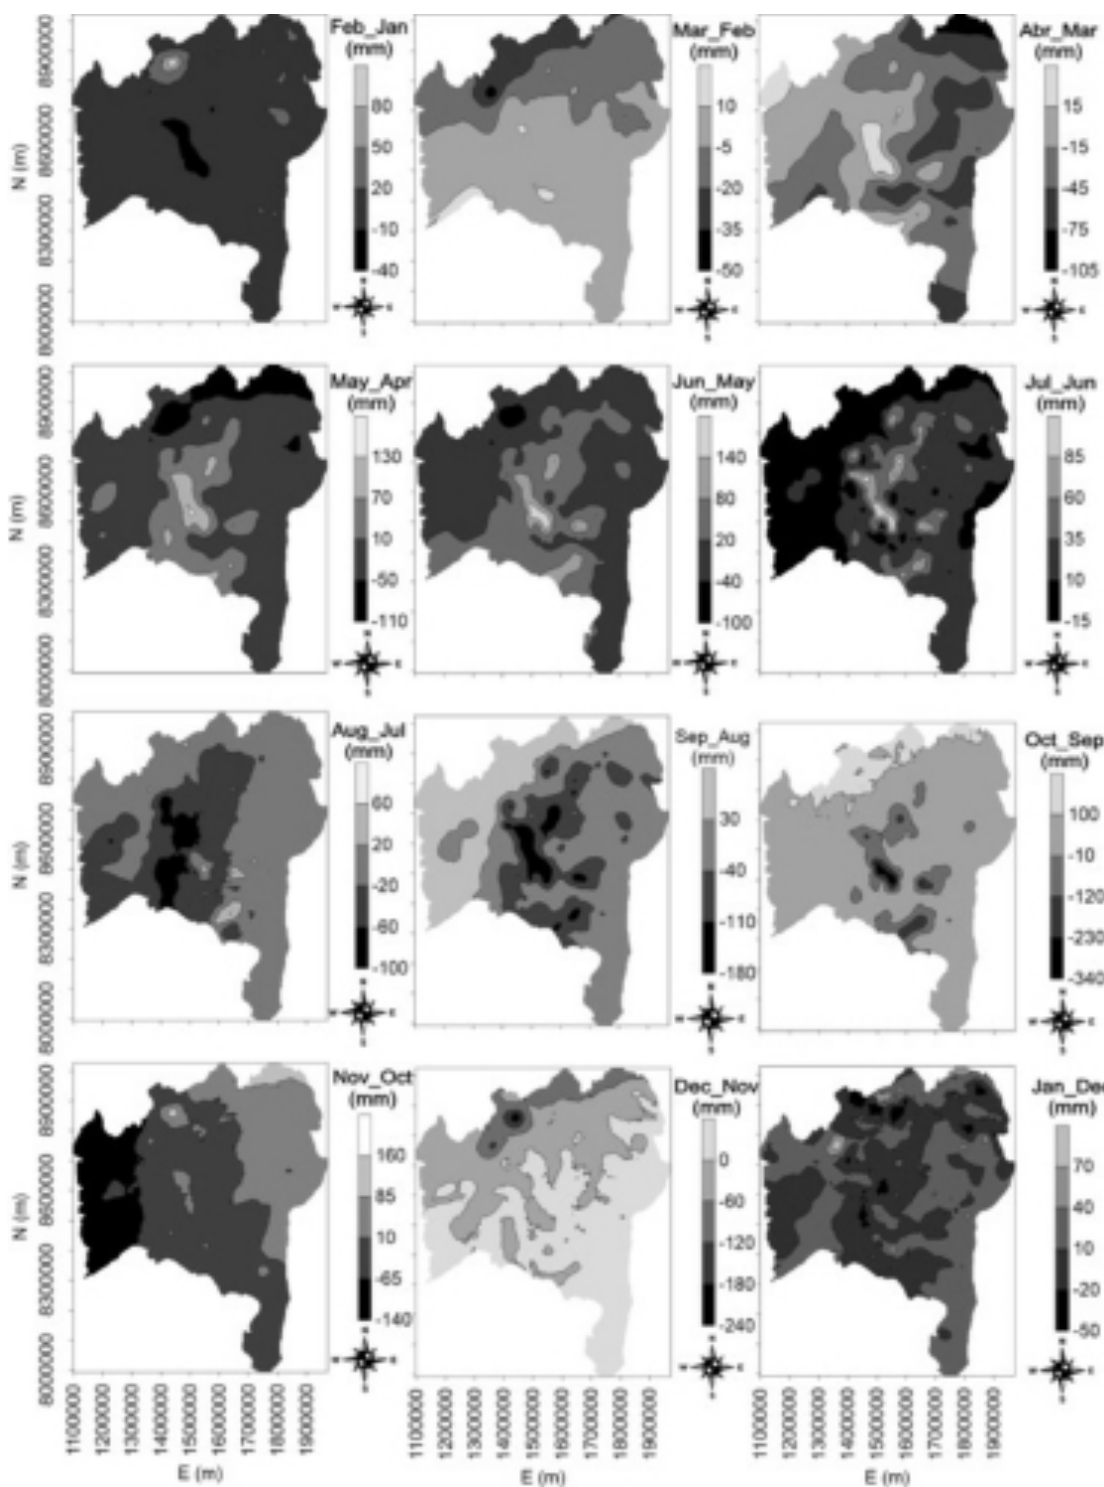
Figure 1. Thematic maps of the month-to-month temporal evolution of rainfall for the state of